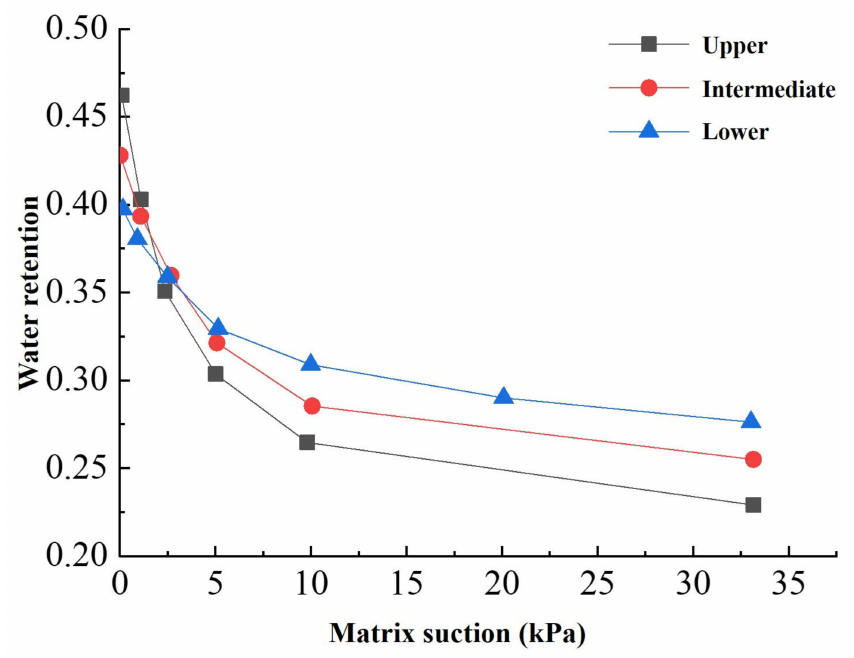
Figure 3. Soil–water retention curve of three layers of MSW in a landfill.